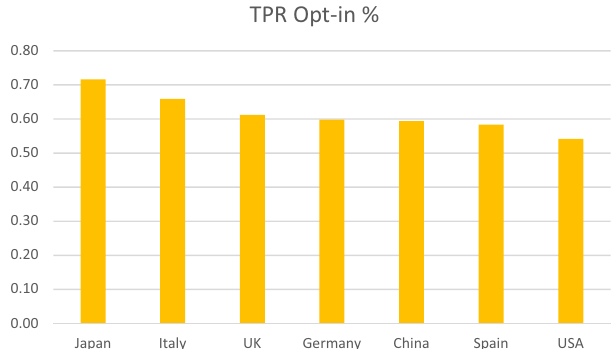
Fig. 2 Geographical distribution of transparent peer review (TPR) opt-in. Representative countries have been selected depending on the number of papers published where the corresponding author was associated with an institution in each